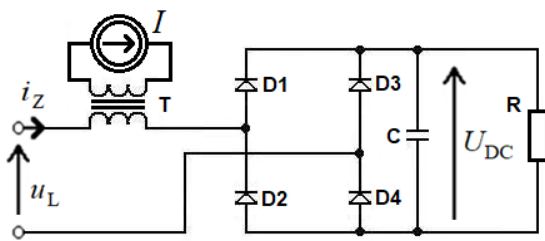
Fig. 1. Diagram of one-phase full bridge rectifier with current